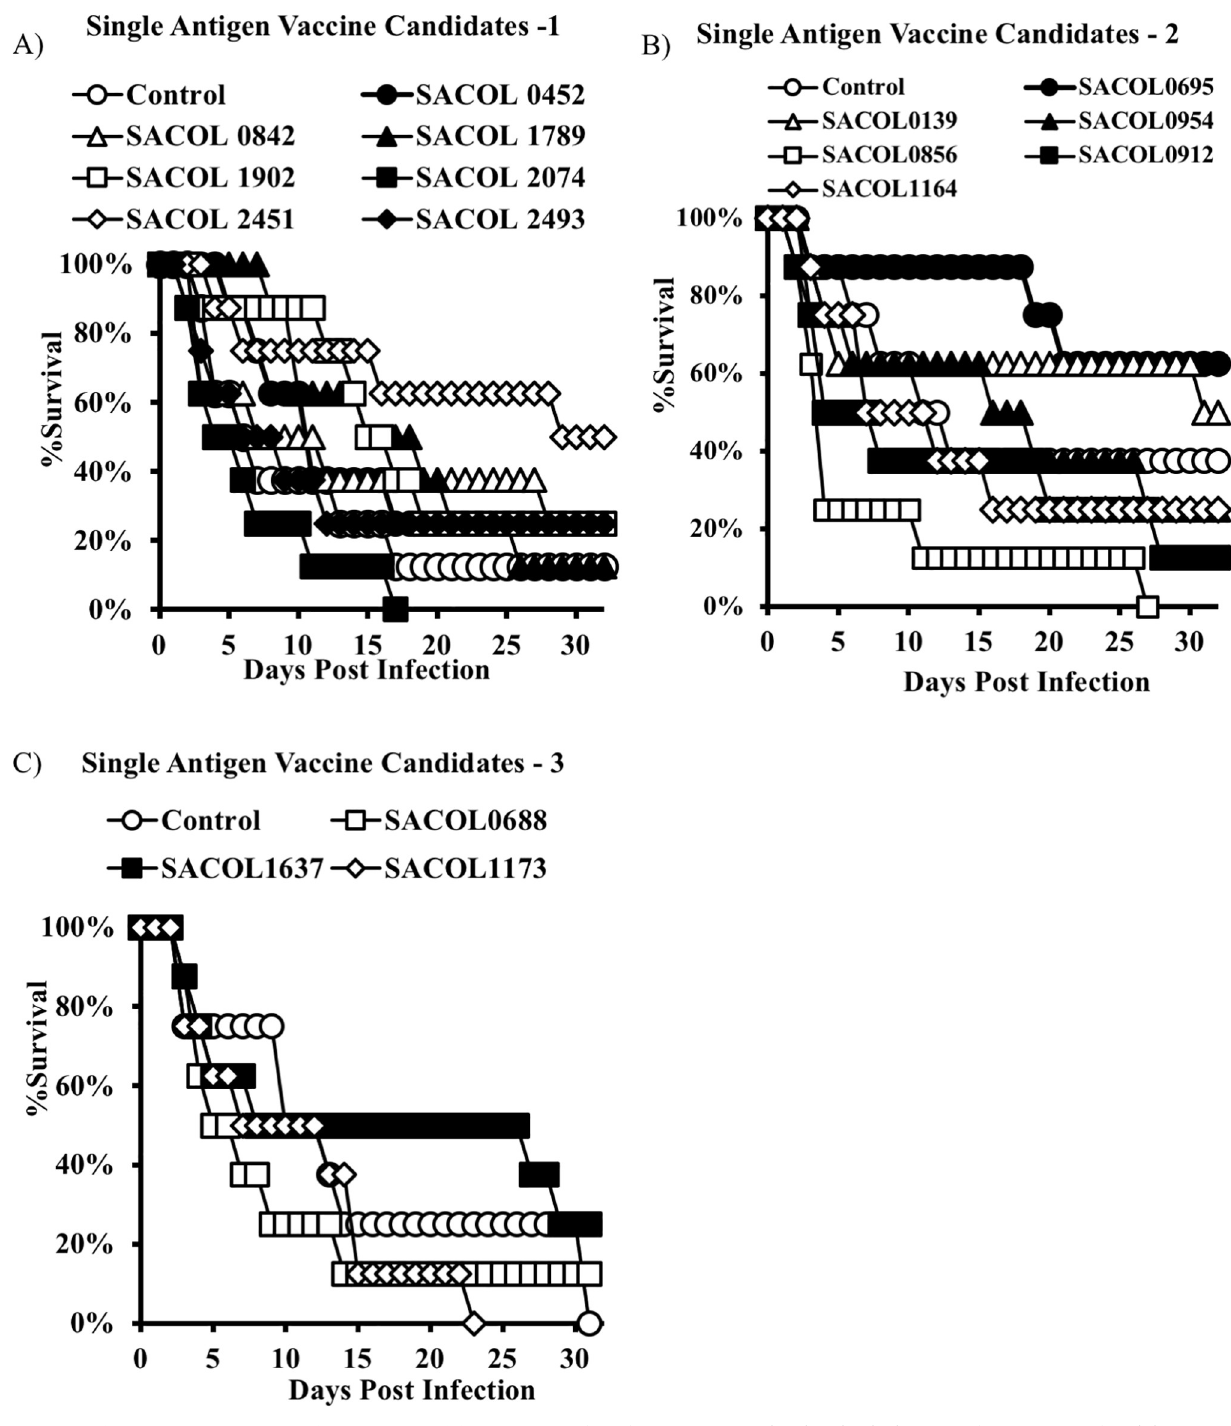
Fig 1. Single antigen immunization, bacteremia model. BALB/c mice (n = 8) were immunized with individual antigens (20 micrograms) and then challenged with a S . aureus IV infection. Mice were monitored daily and euthanized when moribund. Immunization with SACOL2451 and SACOL0695 resulted in the highest percentage of surviving